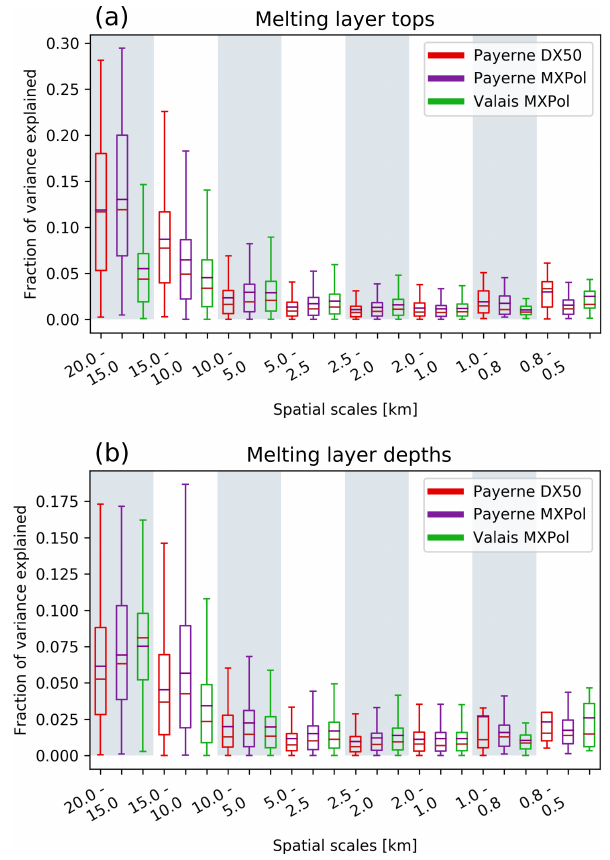
Figure 9. Fractions of variance explained by components for the melting layer tops (a) and the melting layer depths (b) for the DX50 (red), MXPol in Payerne (purple) and MXPol in the Valais (green) (fractions of individual melting layers have been binned based on their corresponding frequency